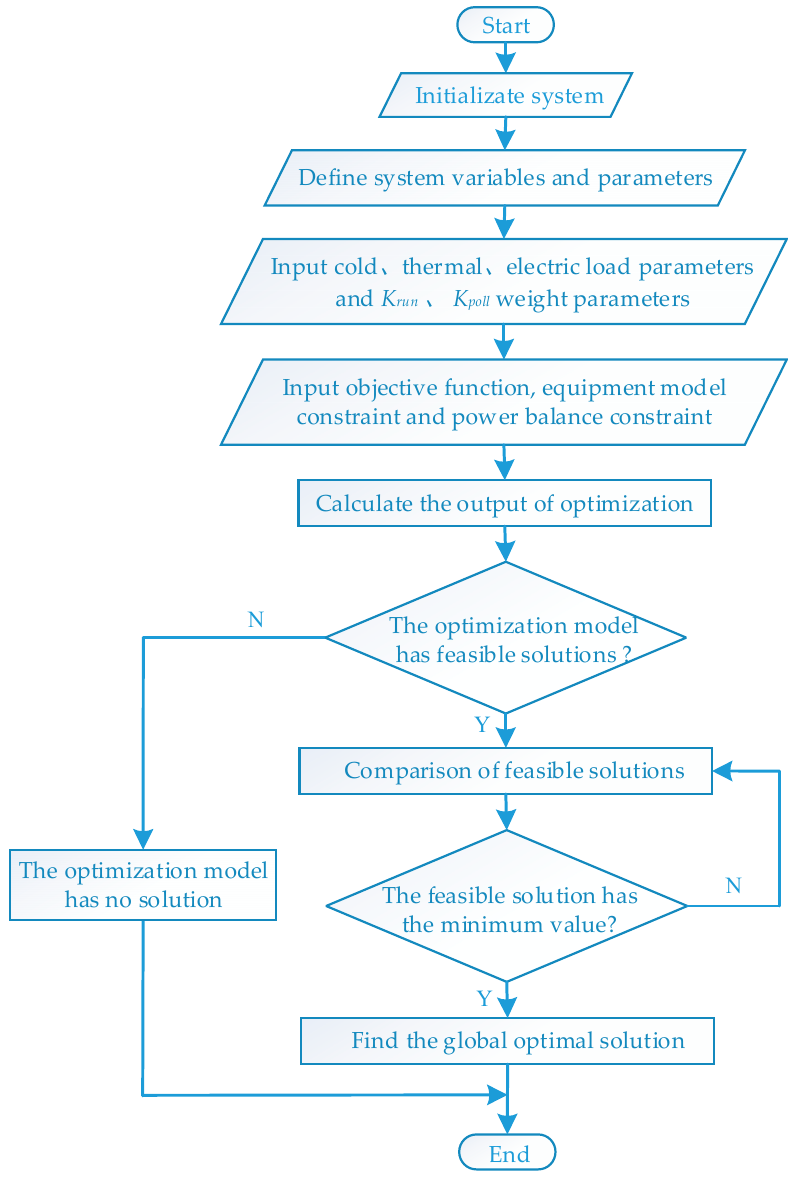
Figure 3. Model optimization process.